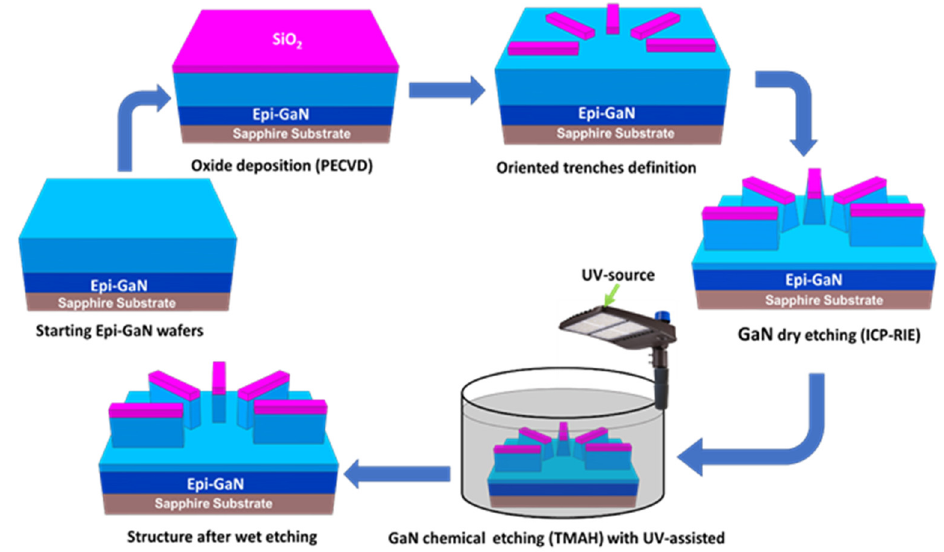
Figure 1 .The fabrication process of GaN’s fingers for sidewalls engineering.